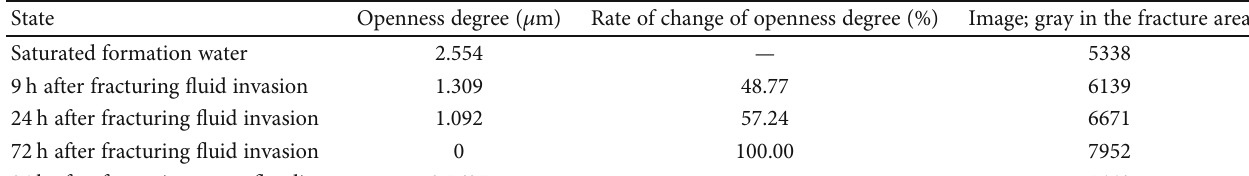
Table 4: Variation of fracture width changes over